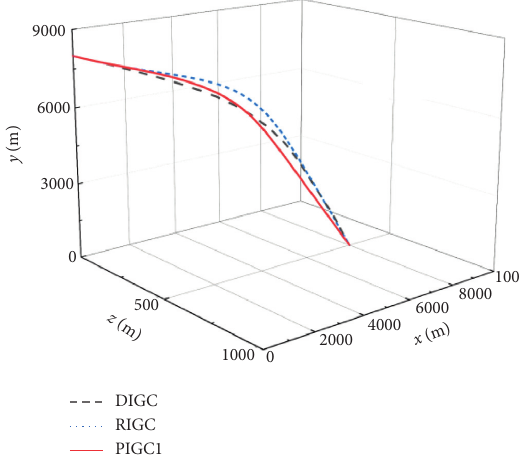
Figure 7: 3D missile and target trajectory curves of Case